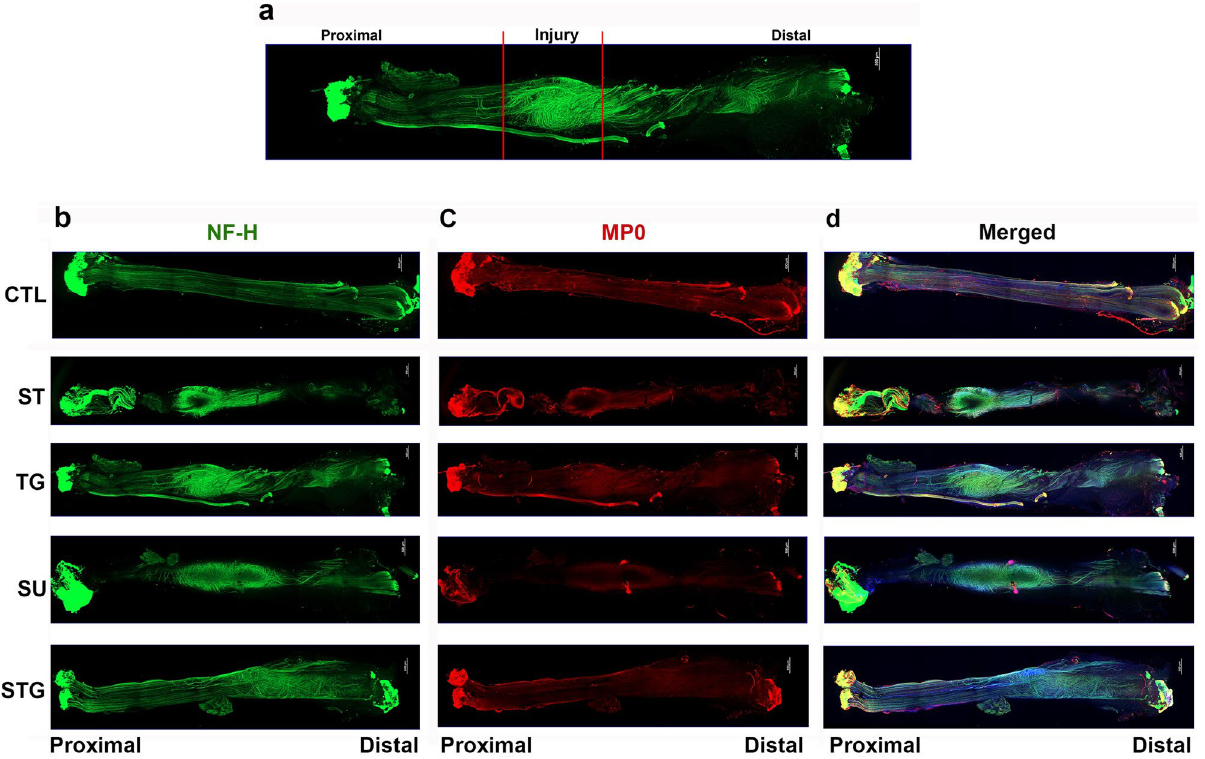
Figure 1. Evaluation of whole mount immunostaining of the transected nerve at post-injury day 28 for nerve fiber distribution. ( a ) For the purpose of evaluation and quantification, imaged whole nerve was divided into 3 zones: proximal, injury and distal. Representative compact images of immunofluorescence staining of the whole nerve for NF-H ( b ) in green, MP0 ( c ) in red, and the merged view ( d ). Scale bar, 500 µm (at upper right corner); magnification, × 5. For other details, see Fig.